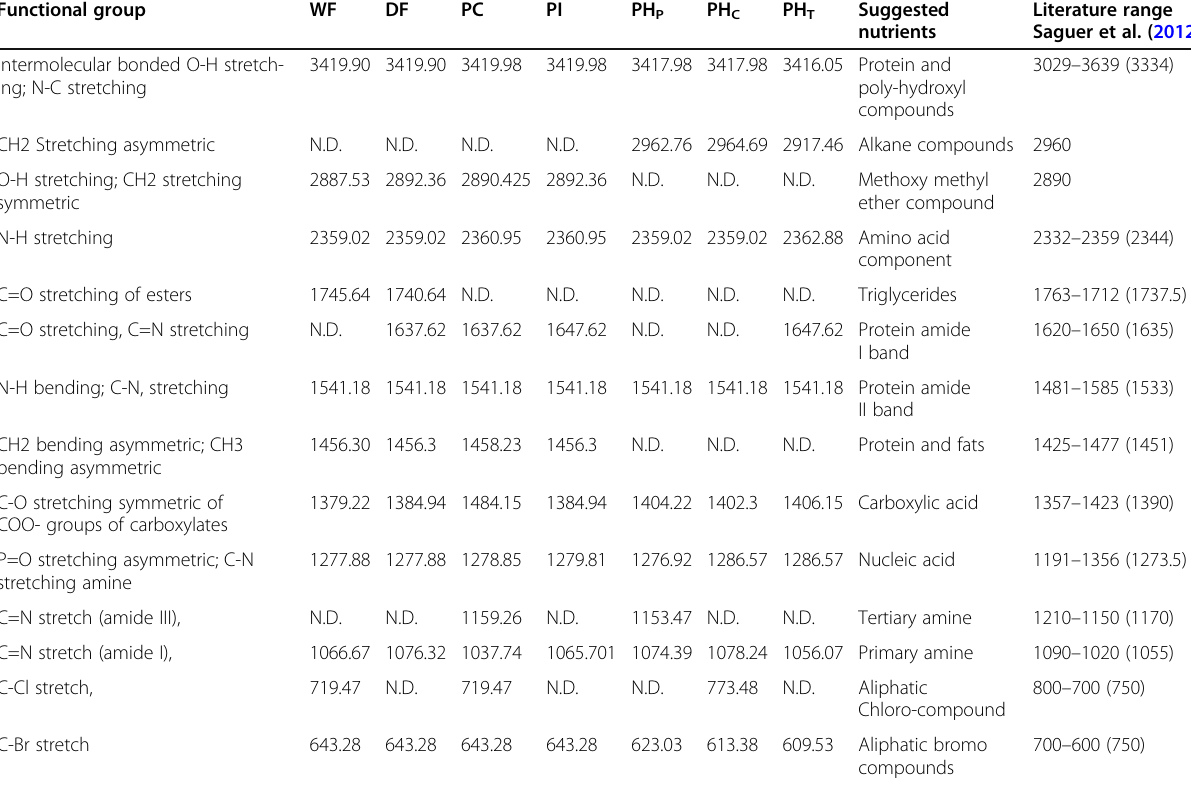
Table 1 FTIR peak assignment for okra seed flours, protein isolate and enzymatic hydrolysates Functional